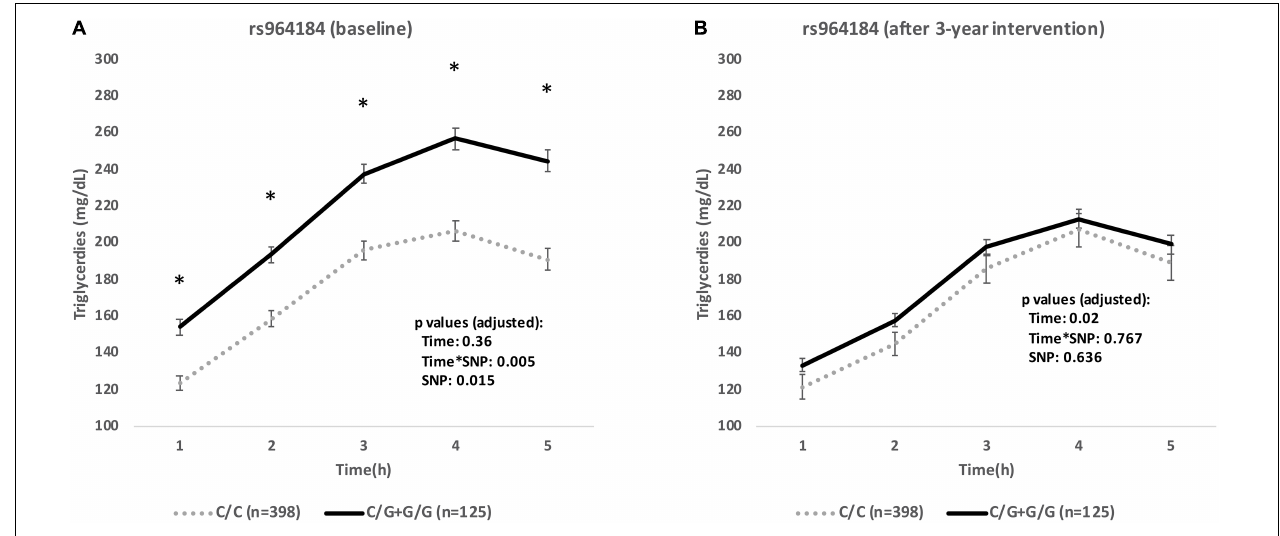
FIGURE 2 | Postprandial triglycerides during baseline oral fat tolerance test (A) and after 3 years (B) of intervention by rs964184 genotypes. Values are means ± SEM. P -values were adjusted for age, gender, lipid-lowering drugs, and body mass index. ∗ P < 0.05.